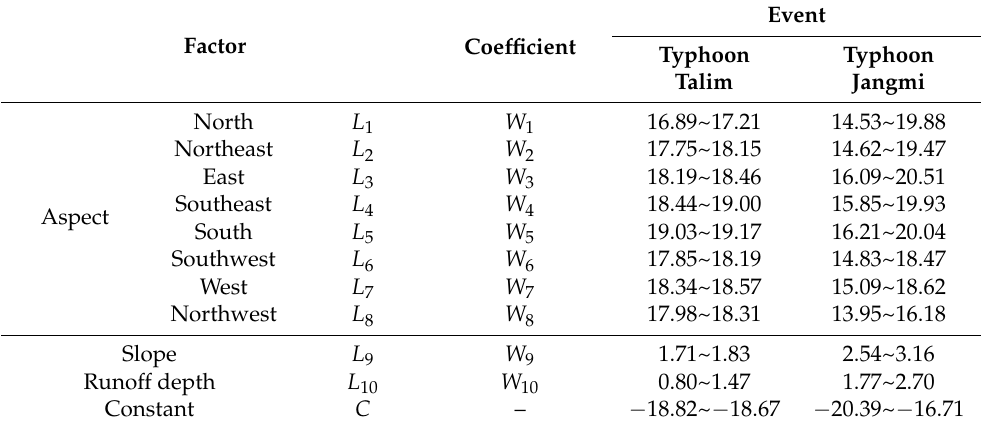
Table 4. Regression coefficients estimated for the logistic regression model.